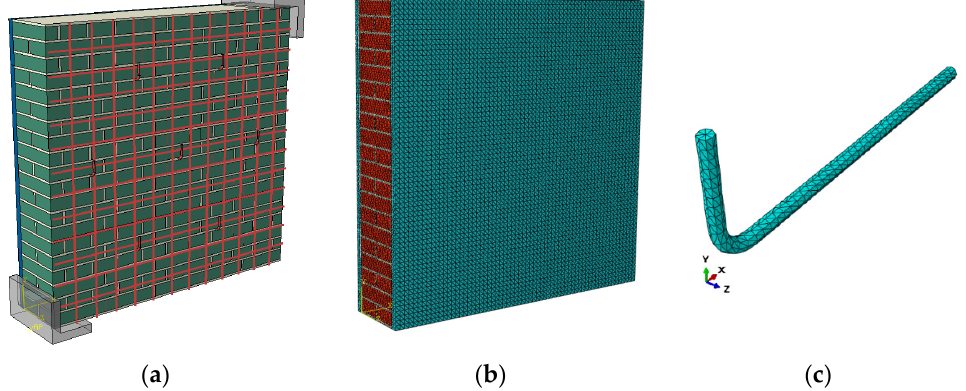
Figure 5. ( a ) 3D model of the specimen; ( b ) FE mesh of reinforced masonry; ( c ) FE mesh of the anchor.